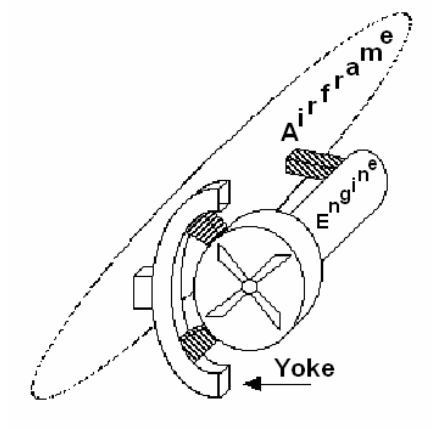
Fig. 2. A jet engine connected to the airframe, via three rubber mounts.